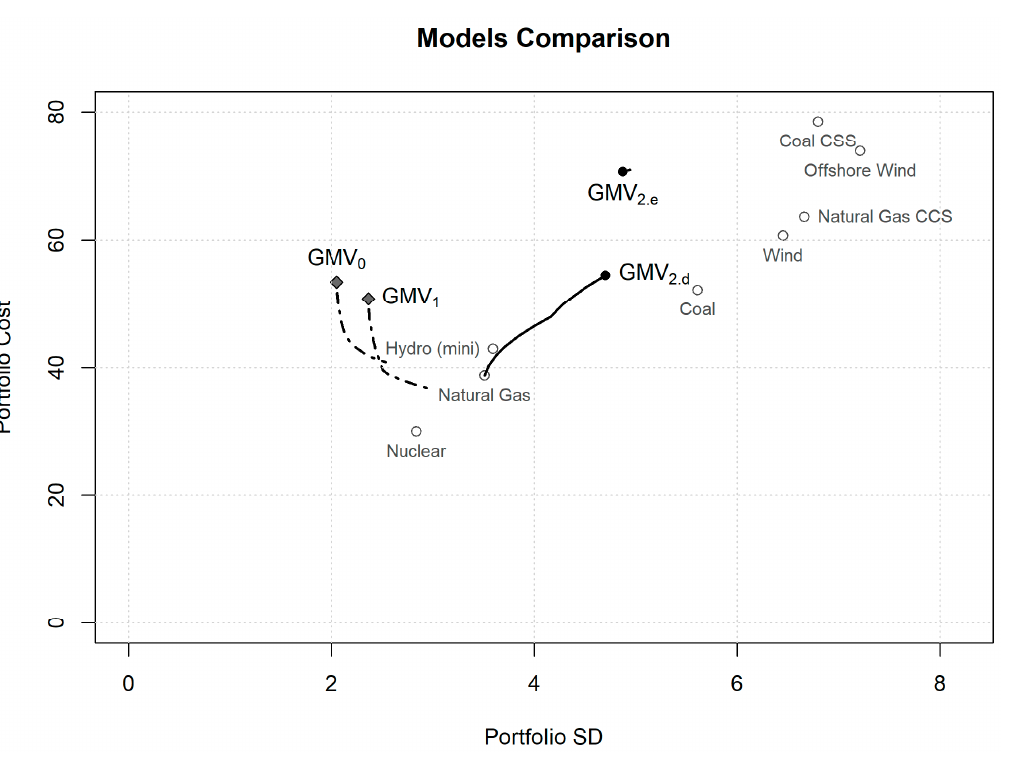
Figure 8. E ffi cient frontiers in a cost-risk Figure 8. Efficient frontiers in a cost-risk plane.